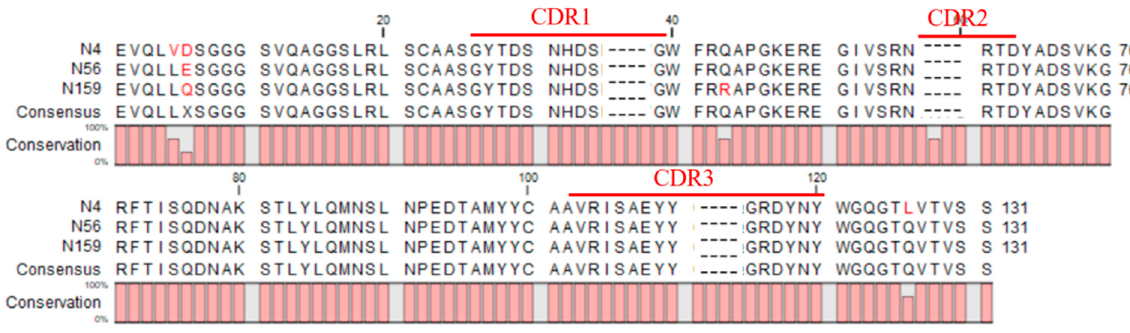
Figure 3. Sequence alignments of the three positive clones.